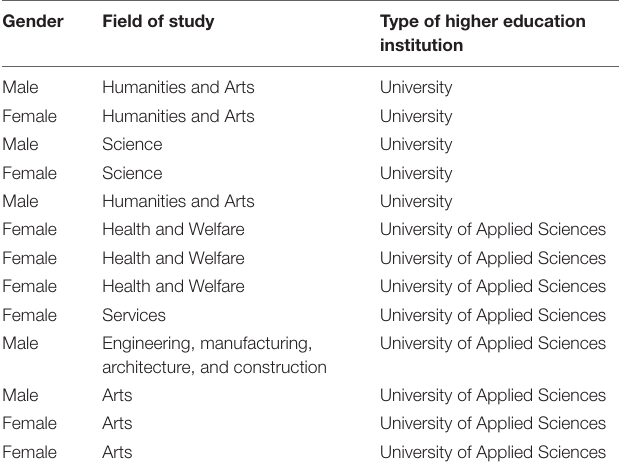
TABLE 1 | Demographics of the participants in the cognitive